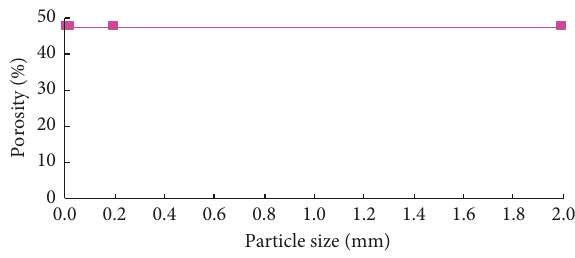
Figure 1: Spatial porosities for different soil